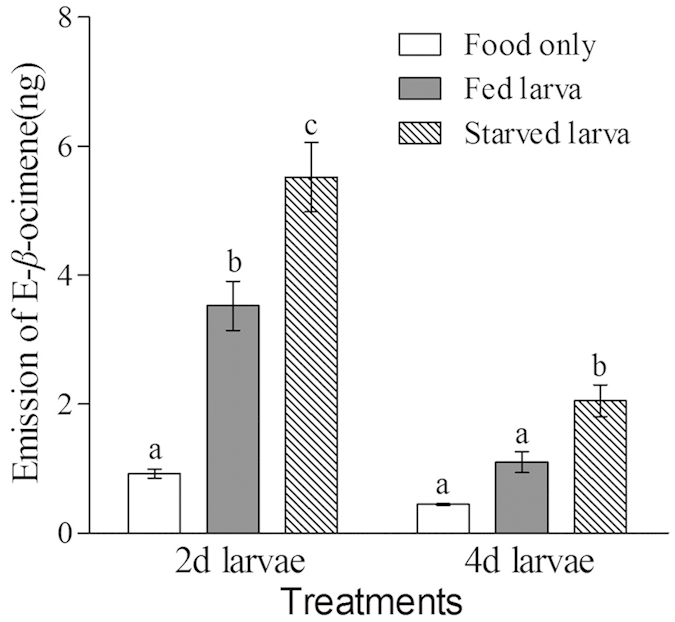
Emission of E-β-ocimene from SL (striped bar), FL (gray bar) and food only (open bar).Mean + SE presented in each bar. 2- and 4-day old SL released significantly more E-β-ocimene compared to FL (2-day old comparison: n = 6, p = 0.013; 4-day old comparison: n = 6, p = 0.009). Different letters “a”,“b” and “c” on top of bars indicate significant difference (Fisher’s PLSD test, P < 0.05, after ANOVA showed an significant effect), whereas same letter indicates non significant difference (ANOVA P > 0.05).